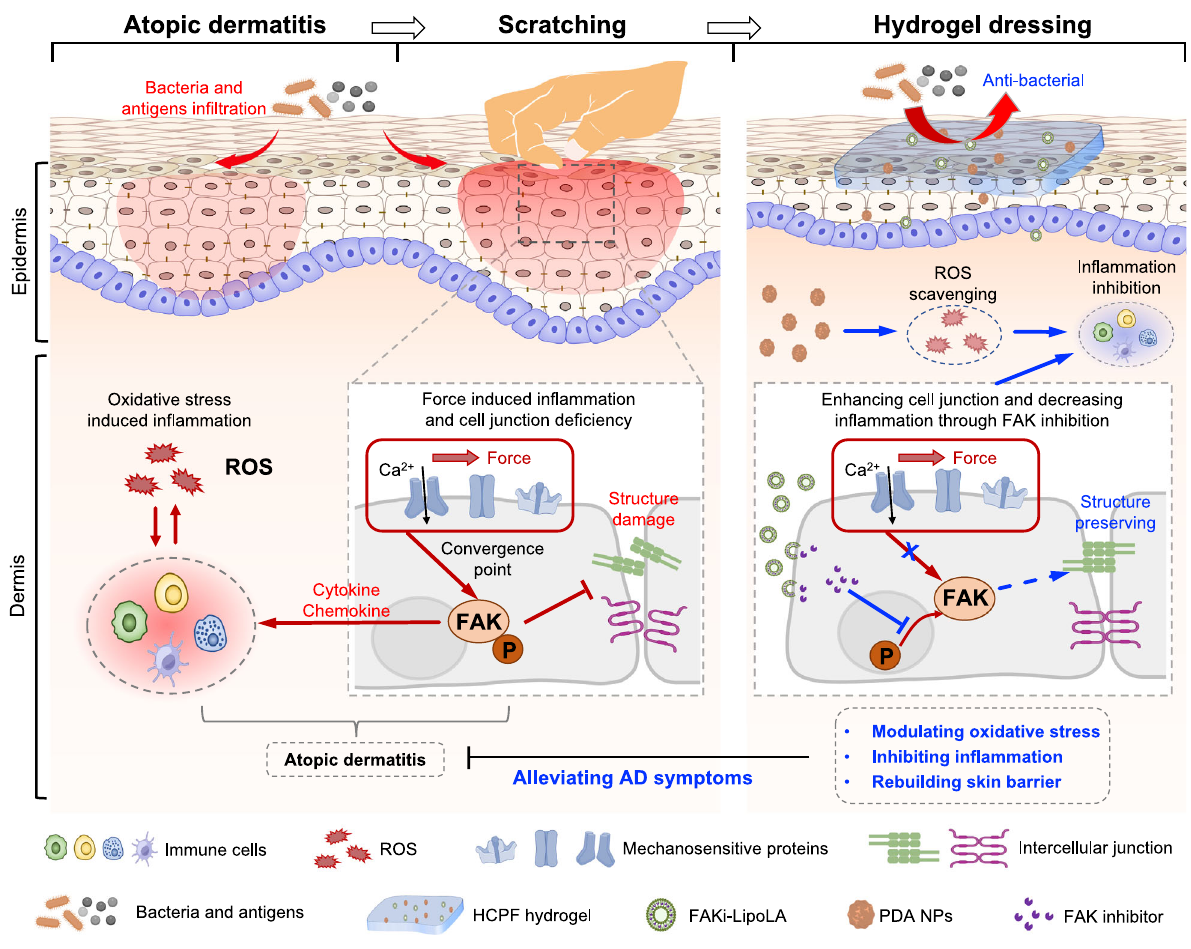
Fig. 1 | Schematic ofHCPFhydrogel for ADtreatment. The left schematic shows the in fl ammatory response of AD due to oxidative stress and the exacerbating effect of mechanical scratching on AD. The right schematic depicts the hydrogel